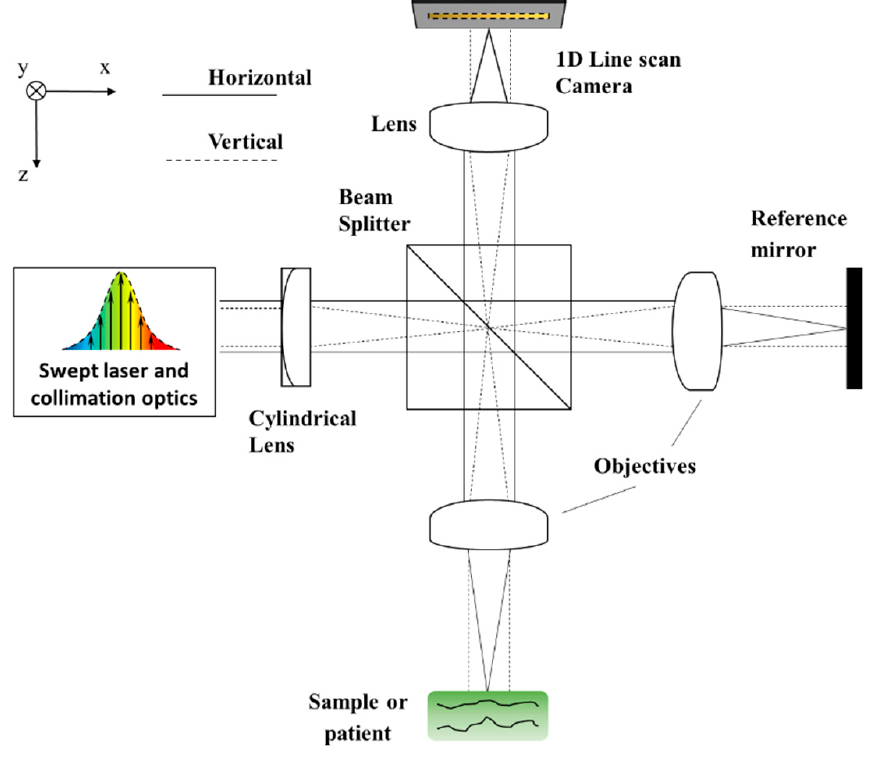
Figure 10. Generic LF-SS-OCT system.